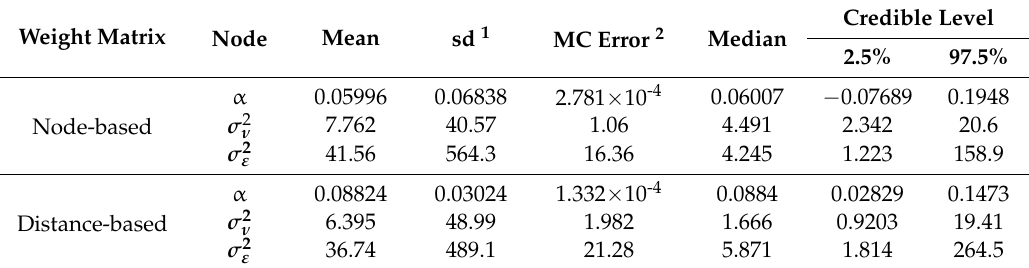
Table 3. The results of the posterior distribution of the parameters.